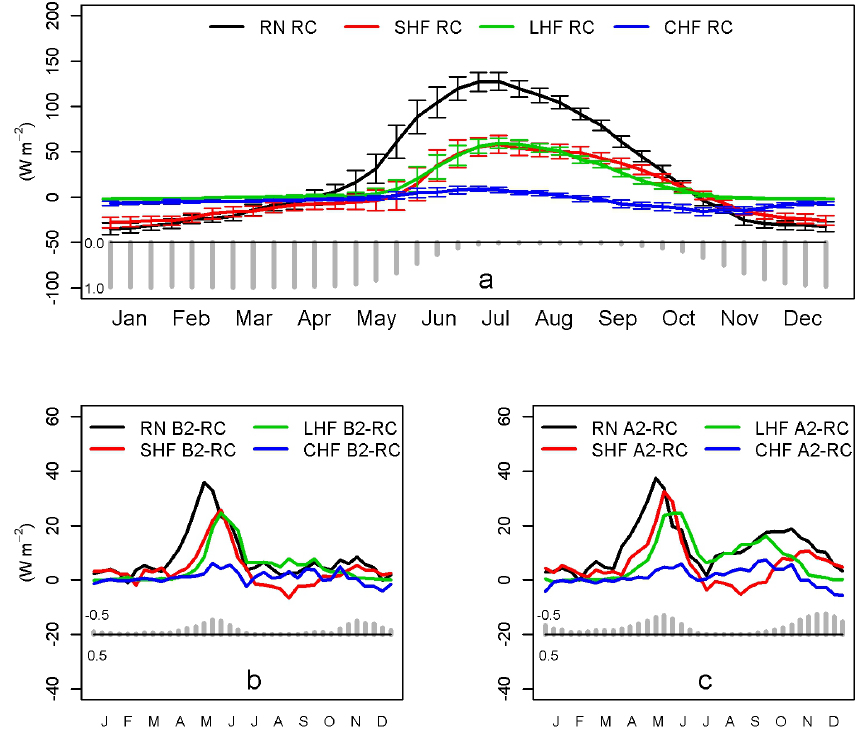
Figure 3. Same as in Figure 2 but for the high mountains (i.e., grid points located above 2000 m a.s.l.). Grey bars in the lower portion in ( a ) represent the snow cover (in m) in the RC varying from 0 to 1 m; in ( b , c ), the snow cover difference ( ∆ SN; in m) between the corresponding FC and RC varies from − 0.5 to 0.5 m. The periods of snow ablation (late spring) and accumulation (mid or late autumn) are well